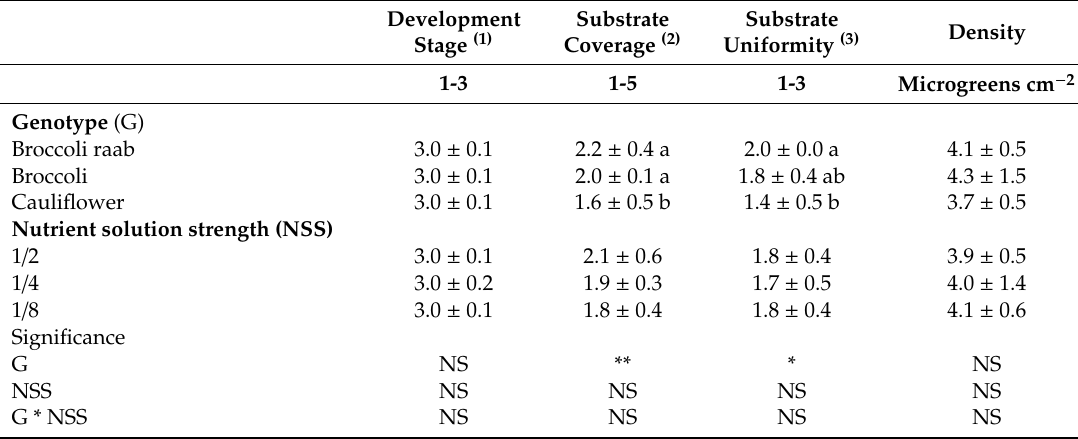
Table 4. Main effects of genotypes and nutrient solution strength on development stage, substrate coverage, substrate uniformity and density of microgreens (first experiment).